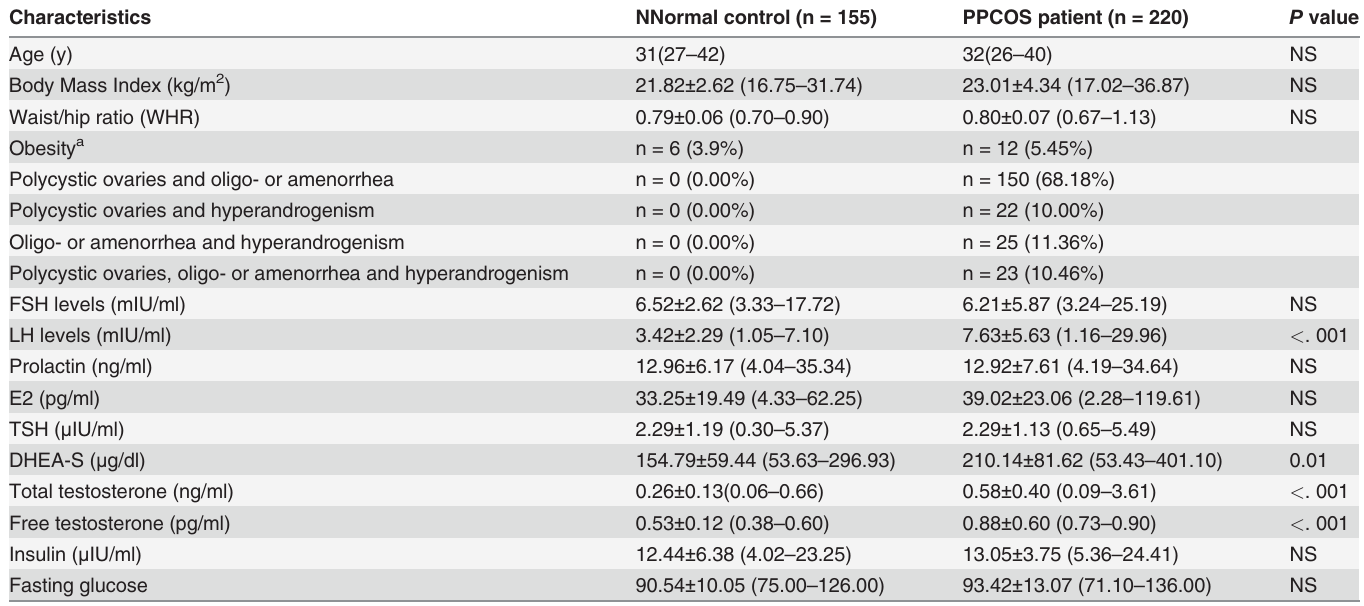
Numerical data were presented as means ± standard deviation (SD) or n